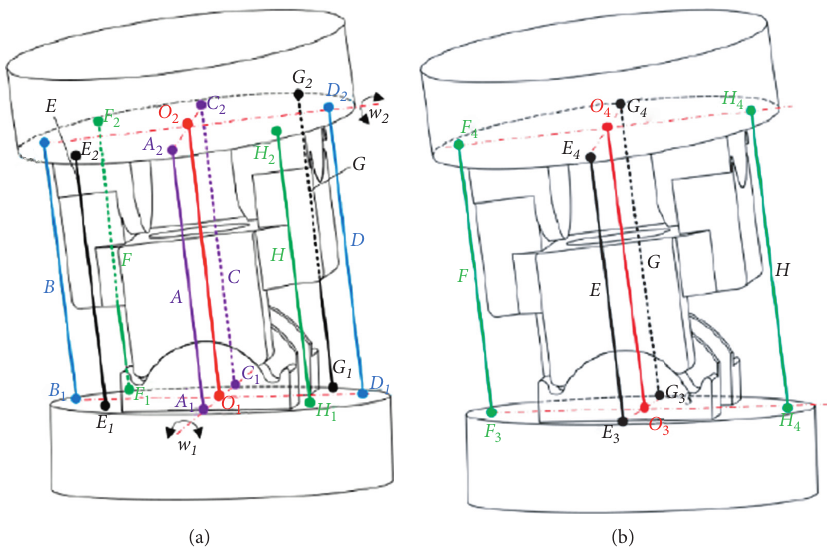
Figure 5: The 2-DOF joint of the proximal and distal segment.